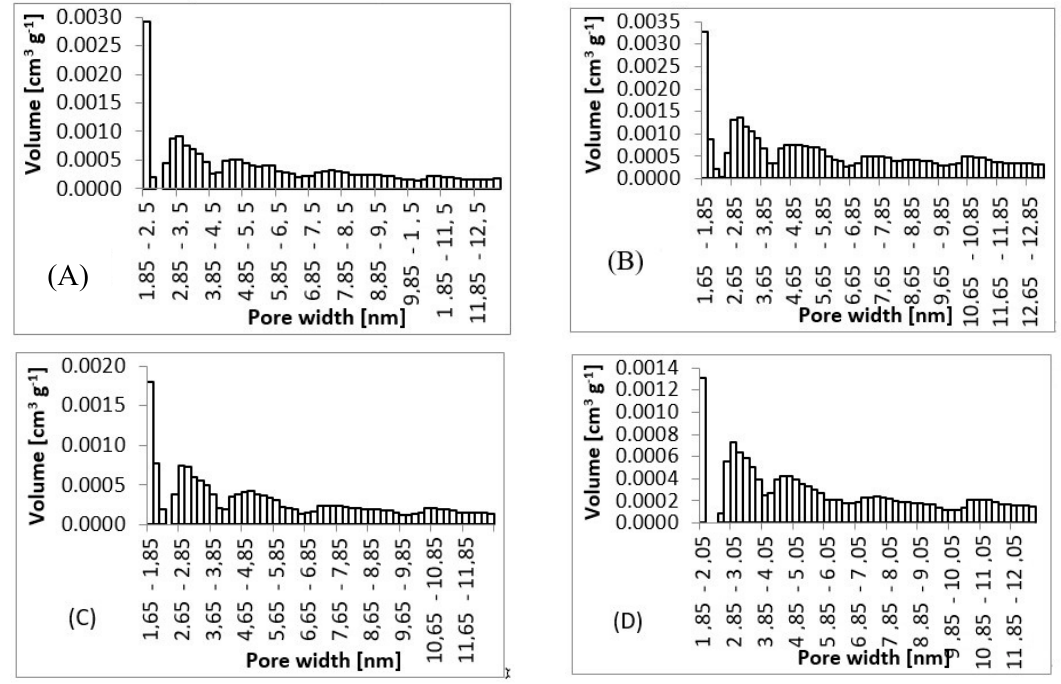
Figure 7. Pore size histograms. ( A ) 3 wt.%; 3 ml.h − 1 , ( B ) 5 wt.%; 0.5 ml.h − 1 , ( C ) 7.5 wt.%; 8 ml.h − 1 , ( D ) 10 wt.%; 8 ml.h − 1 .